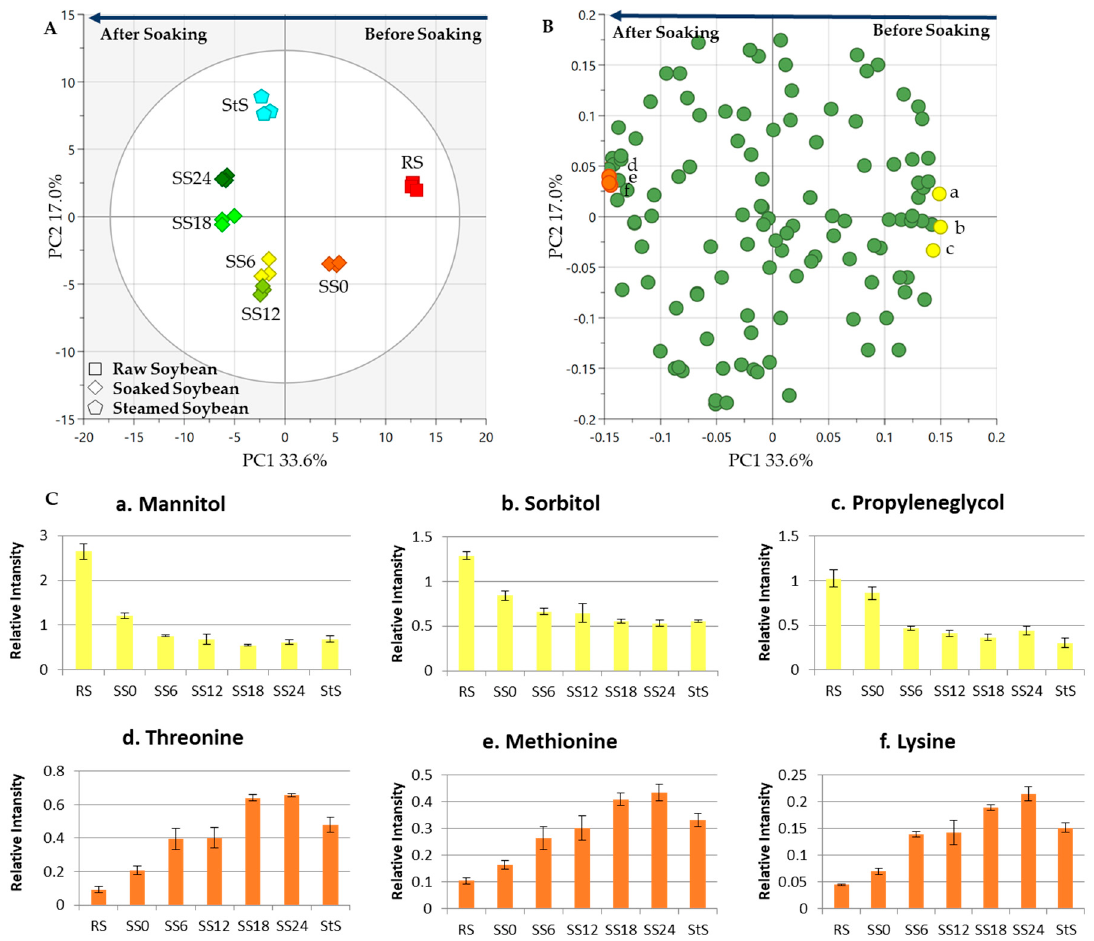
Figure 2. Metabolite changes during the soaking process of soybean. The PCA results of seven soybean samples were obtained to show the metabolite profiles through the soybean soaking process. ( A ) The score plot shows the separation between each sample. RS and SS0 were clustered on the positive side of principal component 1 (PC1), and the other samples clustered on the negative side. The points indicate the treatment times. Different shapes from the legend represent different treatments (RS: raw soybean, SS: soaked soybean, StS: steamed soybean), and the numbers indicate different sampling times in hours (0 h, 6 h, 12 h, 18 h, and 24 h). ( B ) Loading plot. The metabolites discussed in the main text are labeled as follows: (a) mannitol; (b) sorbitol; (c) propylene glycol; (d) threonine; (e) methionine; (f) lysine. ( C ) Bar charts. The metabolites shown in the bar chart are markers from the SS process. The vertical axis represents relative intensity. The horizontal axis represents the samples. The error bar shows the standard deviation obtained from three replicates.